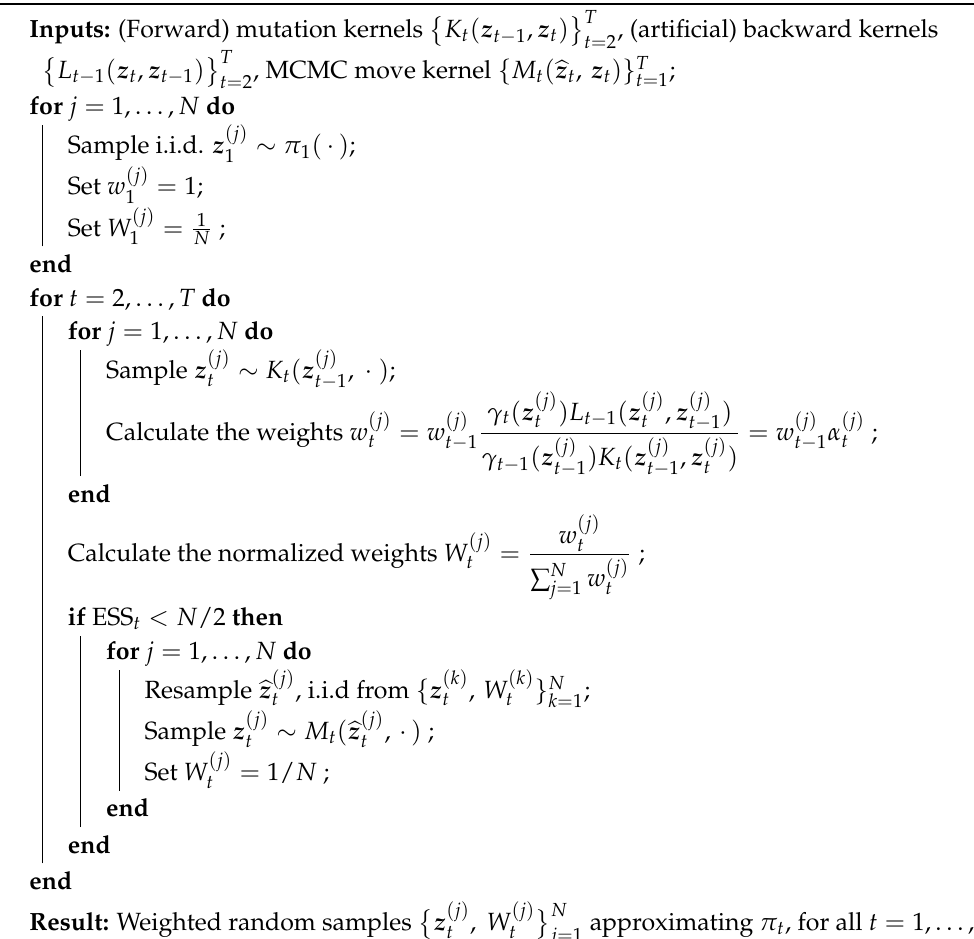
Algorithm 1: SMC sampler